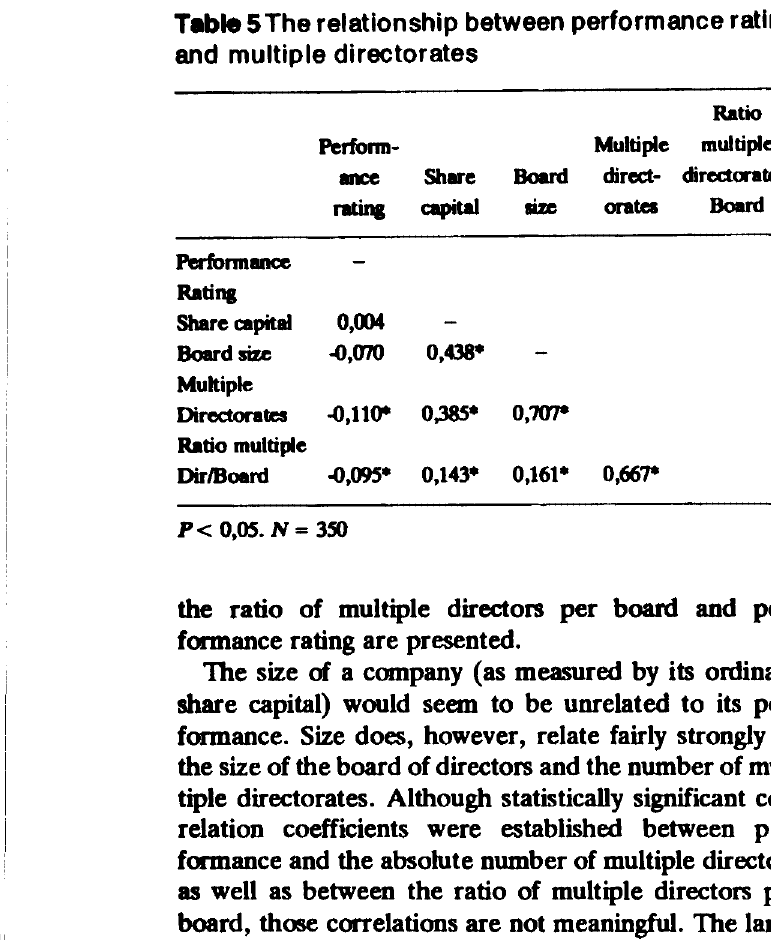
Table7Mean performance rating